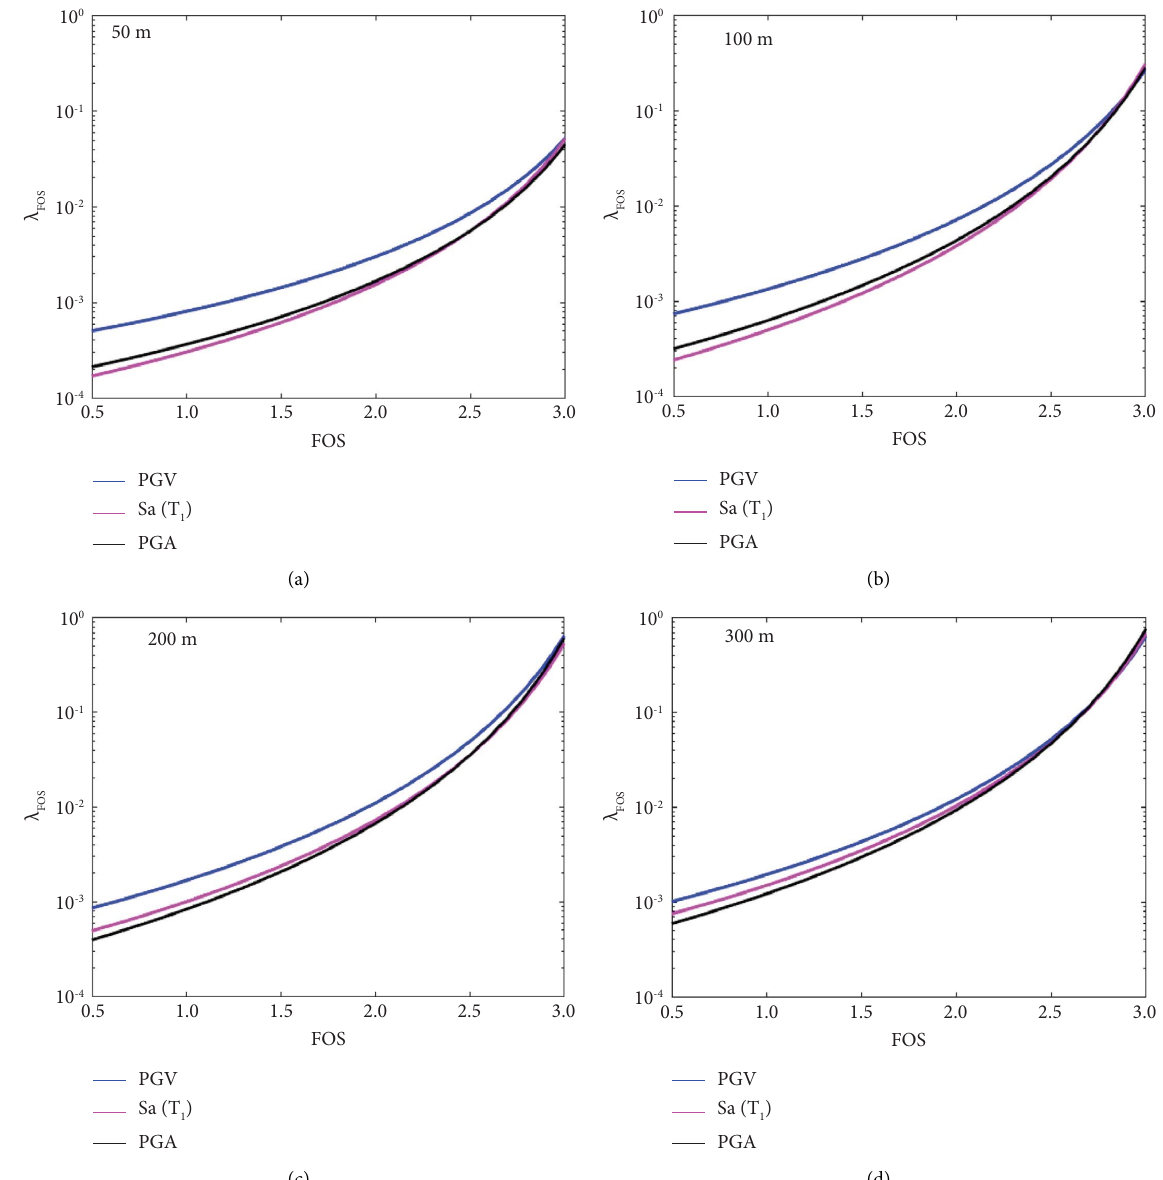
Figure 17: FOS response hazard curves using diferent IMs for the open-pit slopes with diferent mining depths. (a) 50m. (b) 100m. (c) 200m. (d)